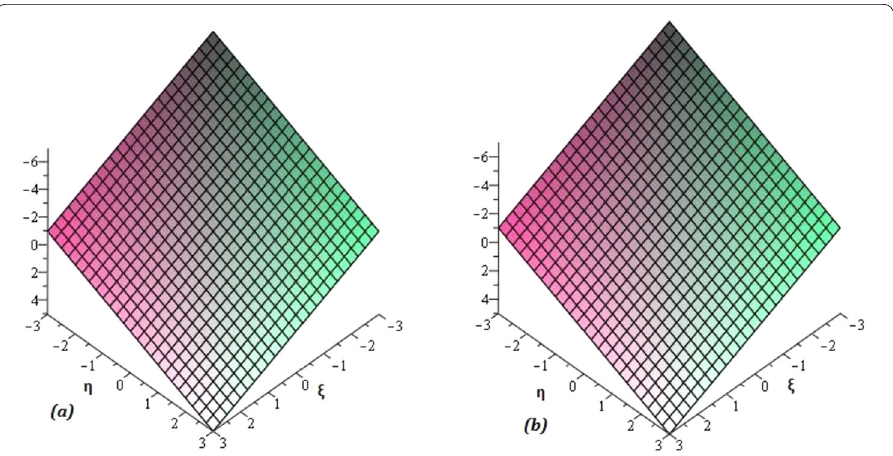
Figure 1 The ( a ) exact and ( b ) LADM solutions graph of Example 1 of u at β = 1 and τ = 0.5